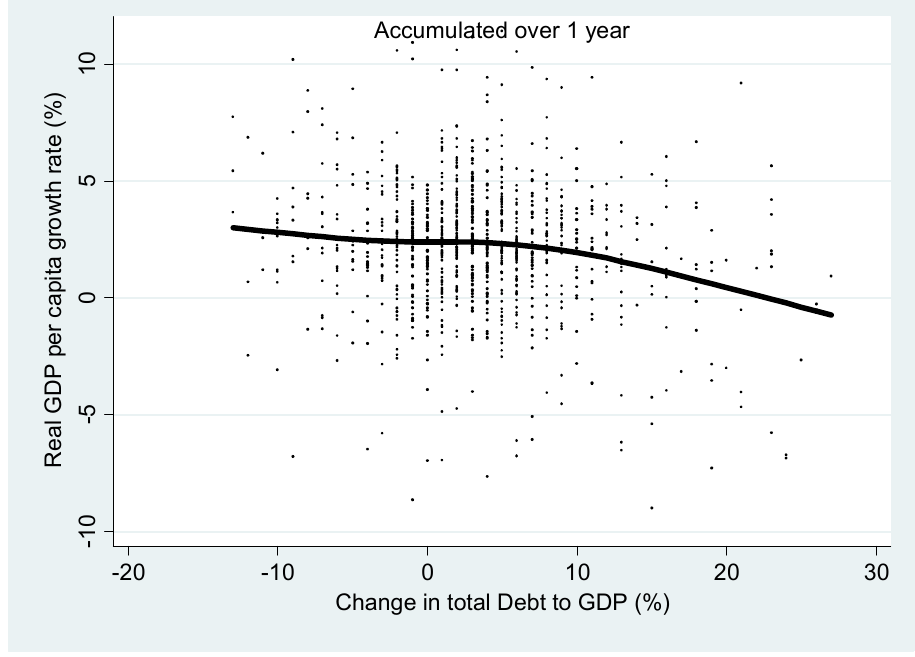
Figure 9 - Change in total debt and short-term economic growth